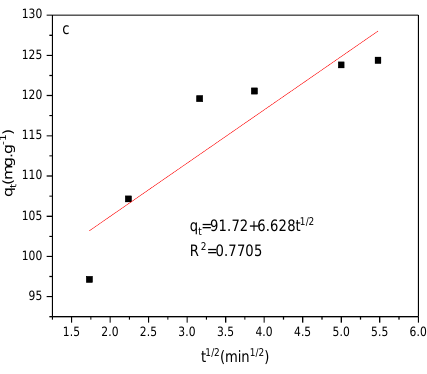
Figure 6. ( a ) Pseudo-first-order, ( b ) pseudo-second-order and ( c ) intra-particle diffusion model at 298 K.